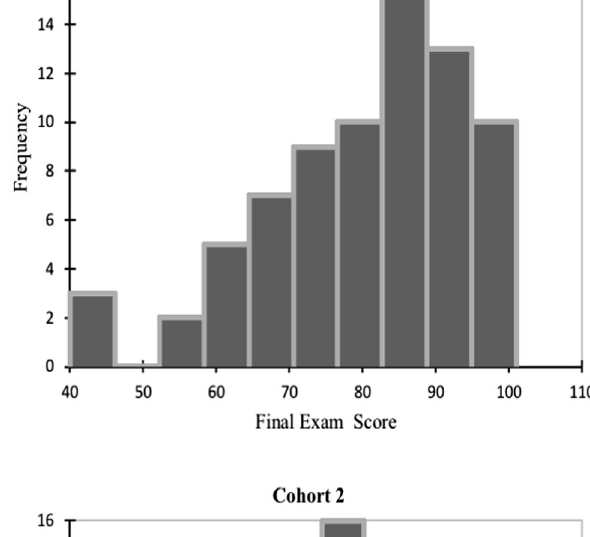
Fig. 2 Histogram of final exam performance in Cohort